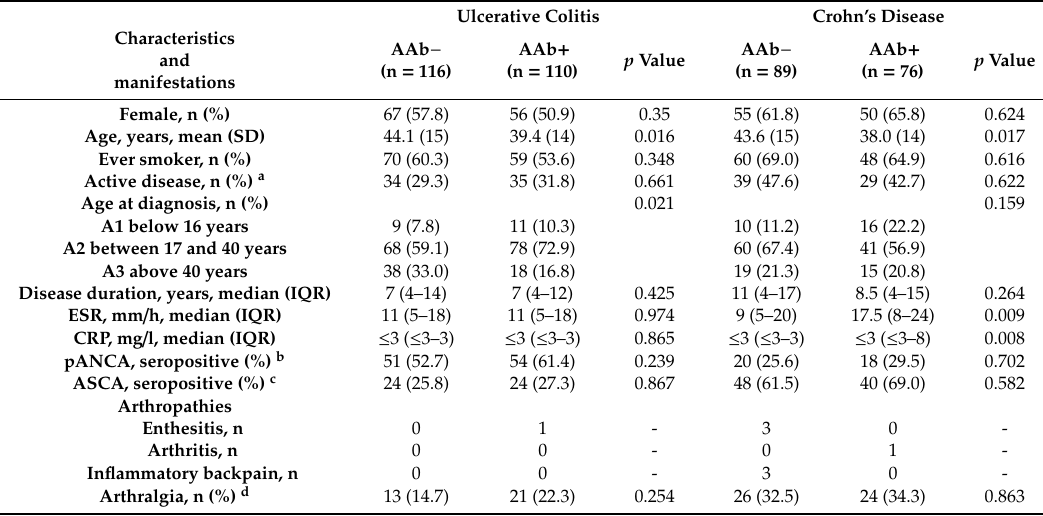
Table 2. Comparison between serological characteristics and articular manifestations in inflammatory bowel disease (IBD) patients subdivided for seropositivity for at least one rheumatoid arthritis (RA) related autoantibody. Ulcerative Colitis Crohn’s Disease Characteristics and